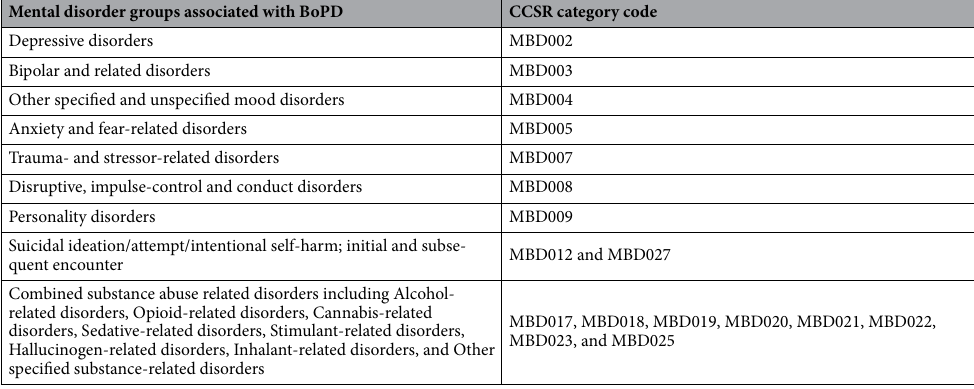
Table 2. Mental disorder groups associated with BoPD and corresponding category code in Clinical Classifications Software Refined (CCSR) version 2020-02 27